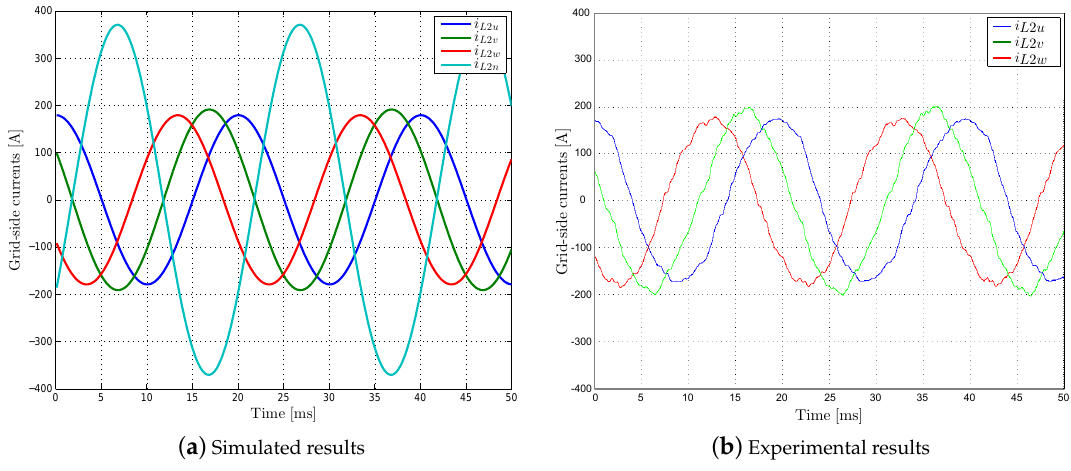
Figure 17. Inverter in grid-connected mode. Unbalanced set-point: P u = P w = 30 kW, P v = − 30 kW and Q uvw = 0